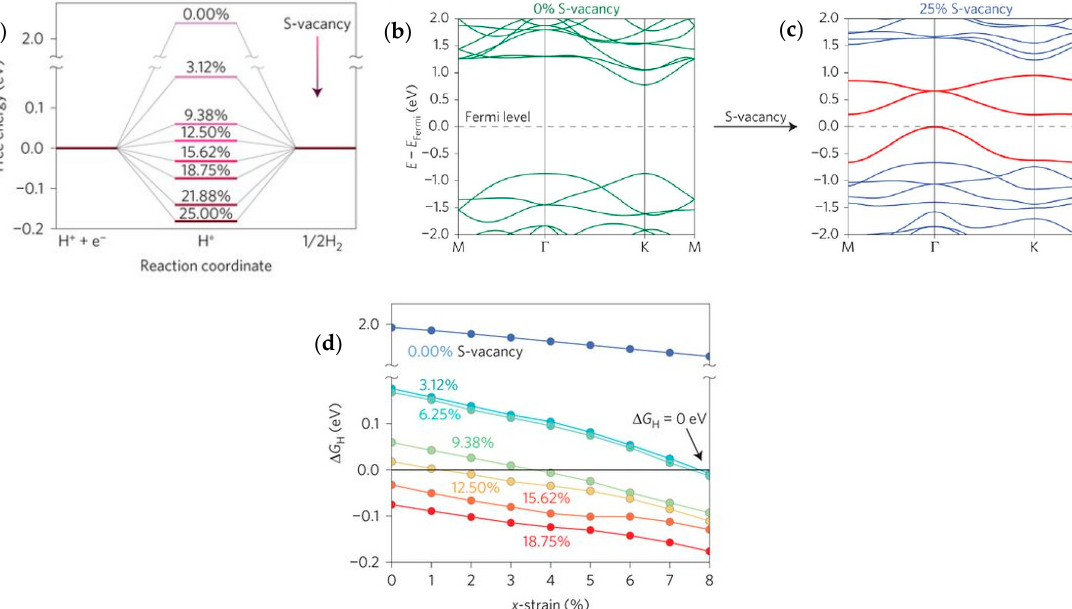
Figure 16. ( a ) Free energy vs. reaction coordinate for HER on basal plane MoS 2 for various vacancy concentrations. ( b , c ) Corresponding band structure, and ( d ) effect of strain and vacancies on ∆ G H . Reprinted with permission from [181]. Copyright 2015 Nature Publishing Group.